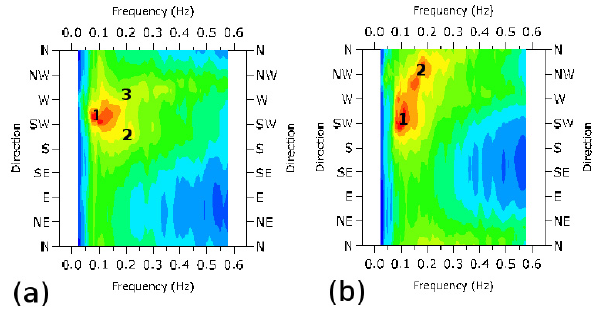
Figure 7. RT buoy directional wave energy spectrum. Colour is proportional to wave energy (m 2 srad − 1 ). Super imposed numbers (black) indicate the main spectral peaks (see text). Left panel (a) 12:00UTC on 1 January 2010 (arrival of the distant swell). Right panel (b) 19:00UTC on 2 January 2010 (decaying phase). The graphical format of these plots is di ff erent from the model’s di- rectional plots because buoy data are processed by a proprietary software of Datawell (Waves@21) that allows only this kind of rep-